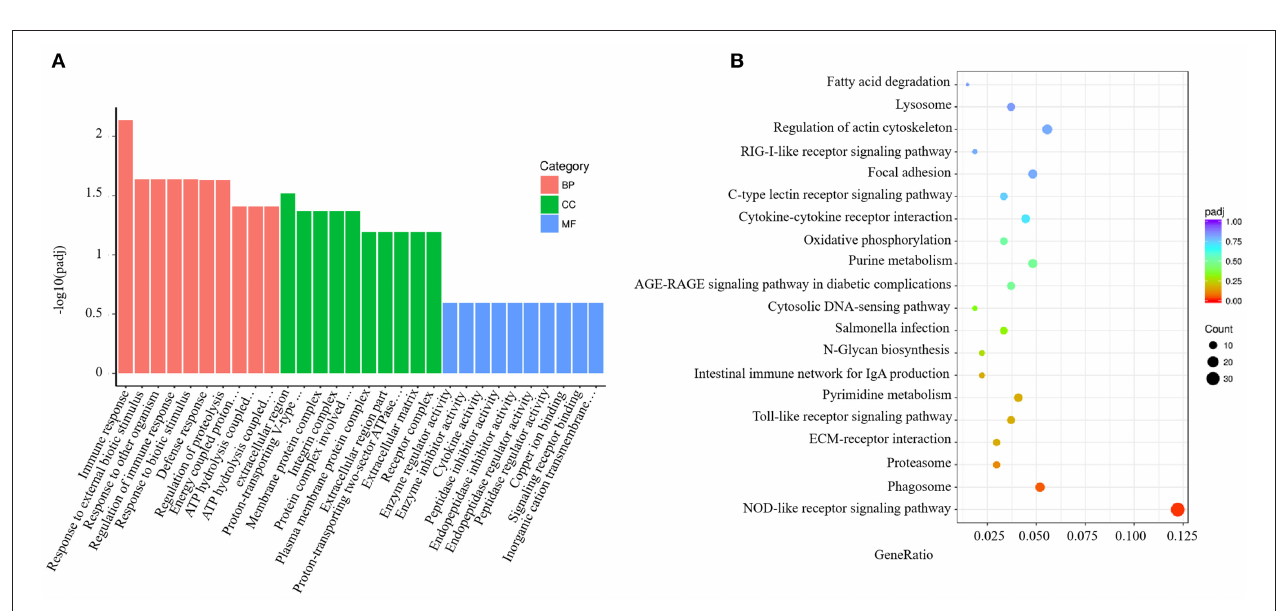
FIGURE 2 | Enrichment GO and KEGG annotation in the spleen infected by V. harveyi . Top GO categories in the spleen are shown in (A) . KEGG category of DEGs in the spleen infected by V. harveyi is shown in (B)